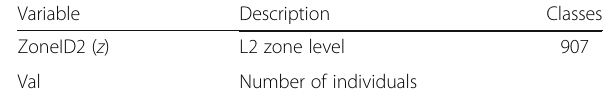
Table 8 Target Q ( z ) for L2 zone level